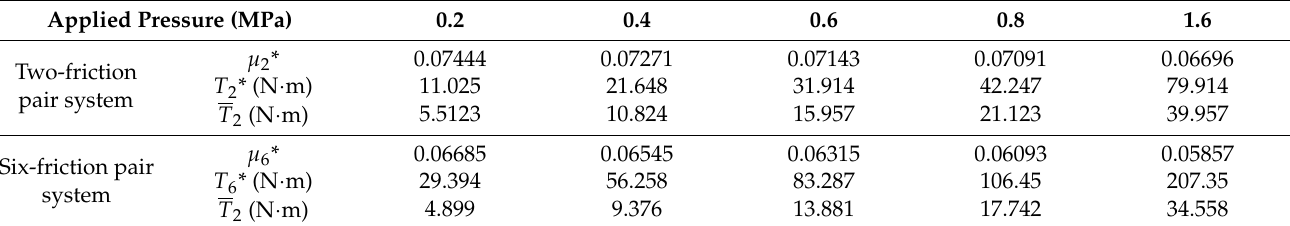
Table 2. Mean values of the two systems.